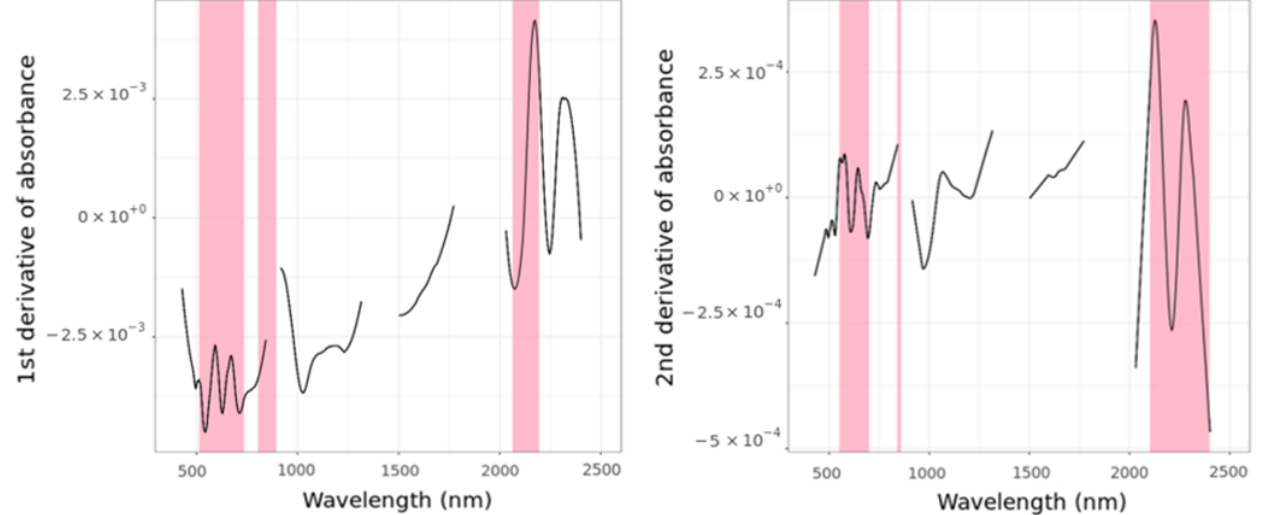
Figure 9. 1st and 2nd derivatives of the HySpex spectral signature with a high OM content. The important spectral regions are highlighted in pink. The interval size varies according to the preprocessing method applied.